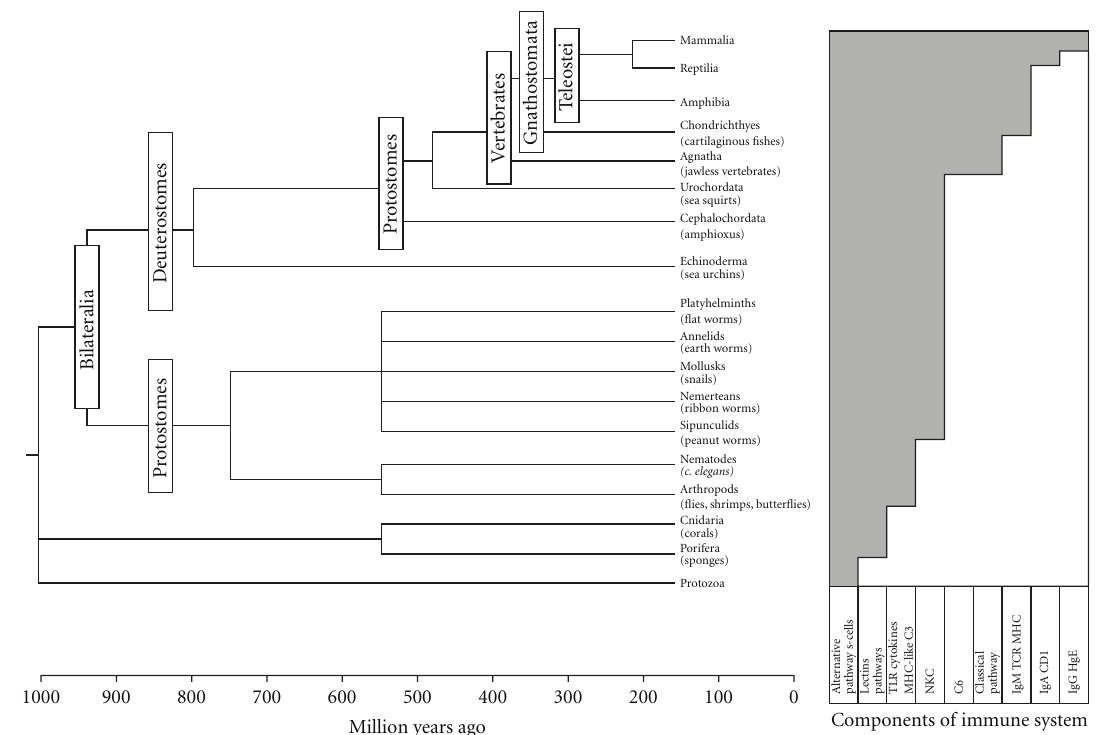
Figure 1: Phylogeny of animals and their immune system. Notice the form of accumulative evolution of the immune system from an innate to an adaptive